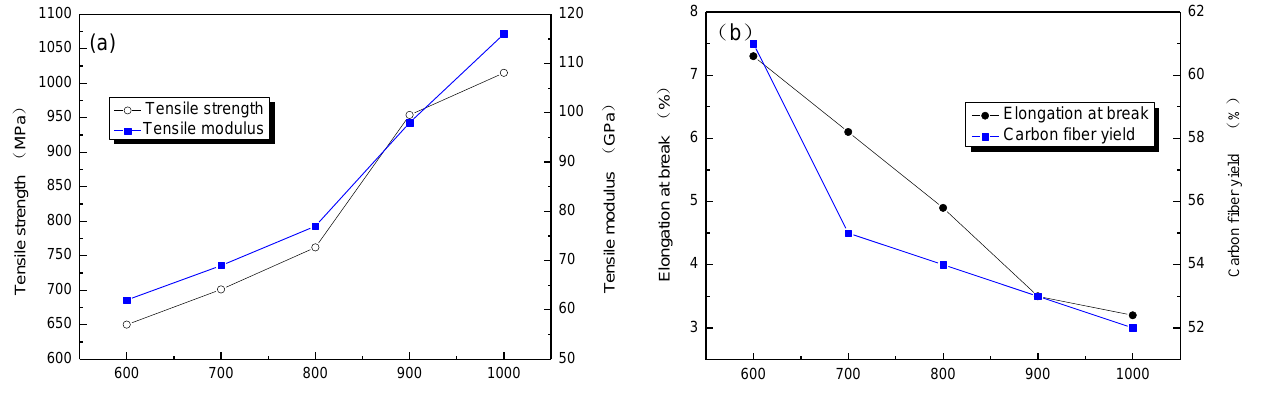
Figure 2. The mechanical properties of CBCFs: ( a ) Tensile strength; ( b ) Elongation at break and Carbon fiber